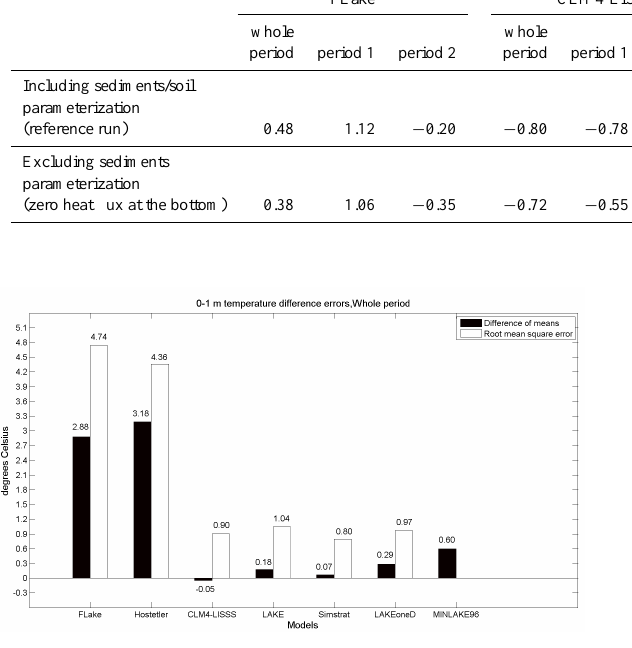
Fig. 5. Difference between modeled and observed means and mo- dels’ RMSEs of δT 0 − 1 (temperature difference between 0 and 1m